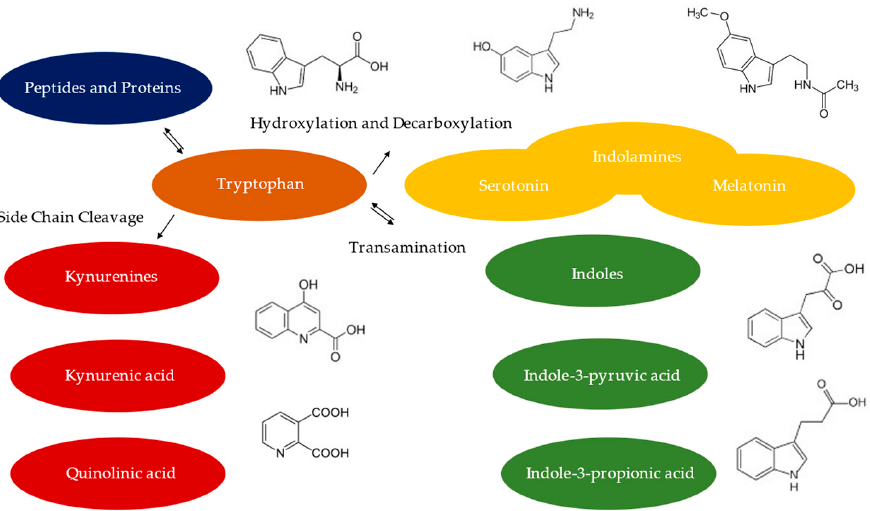
Figure 1. Three tryptophan pathways leading to endogenous indolamines, kynurenines and indoles.